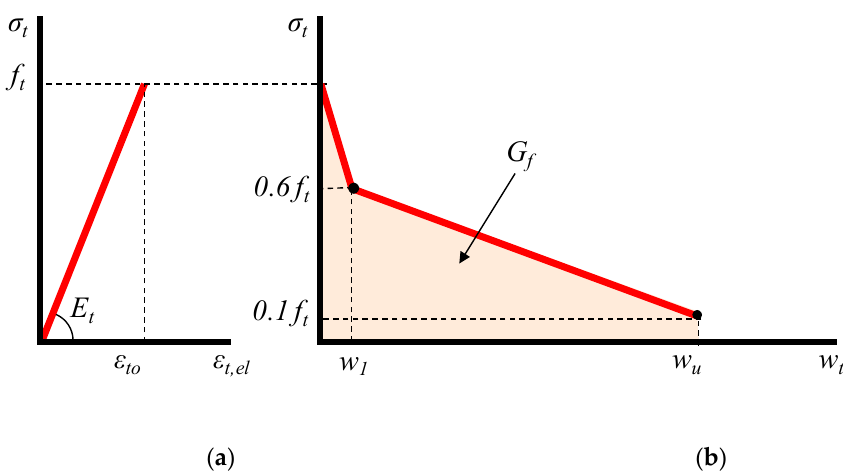
Figure 7. Tensile model of concrete including ( a ) stress versus strain elastic response and ( b ) stress versus crack width post-cracking response with tension softening.